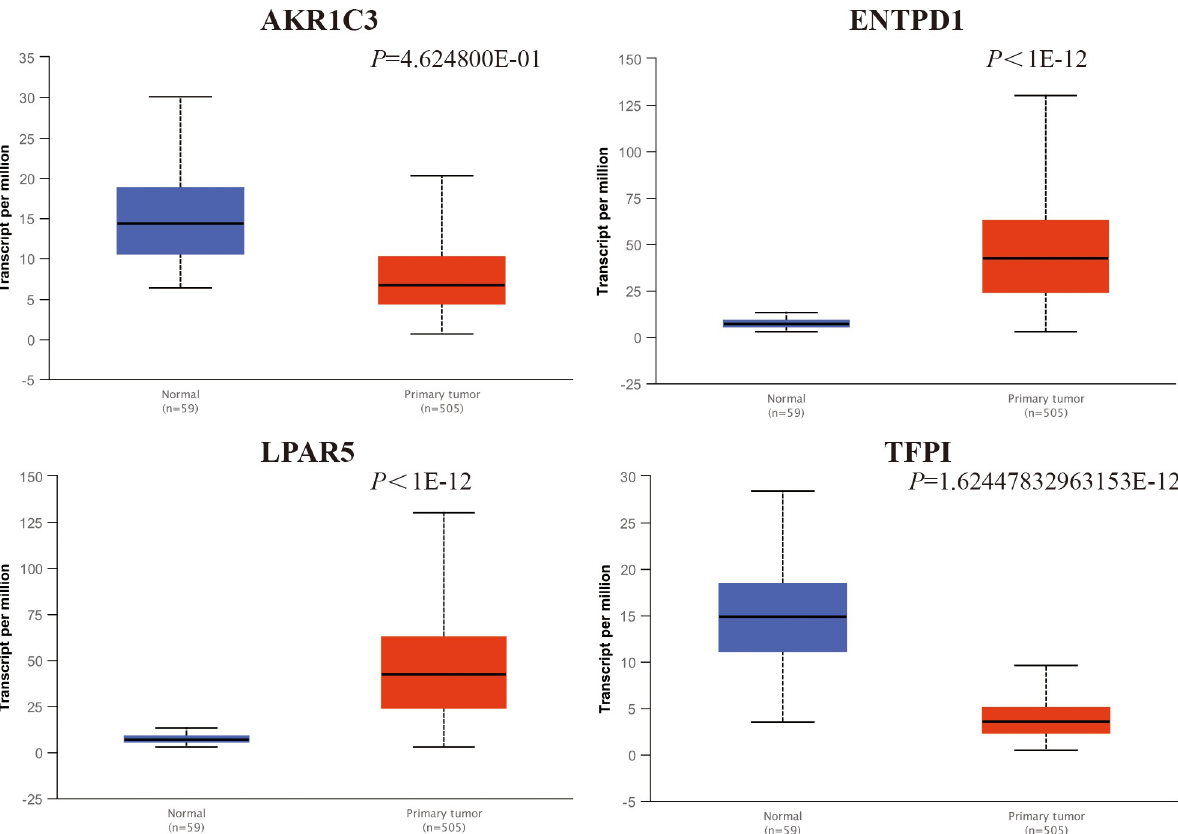
Fig 7. Analysis of hub gene expression levels with UALCAN analysis. The transcript expression comparison of four genes in normal (n = 59) and tumor (n = 505) tissues via UALCAN.